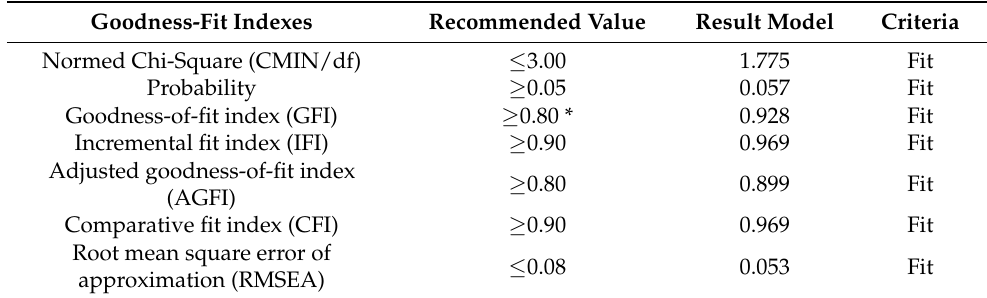
Table 6. Model-fit indices for the